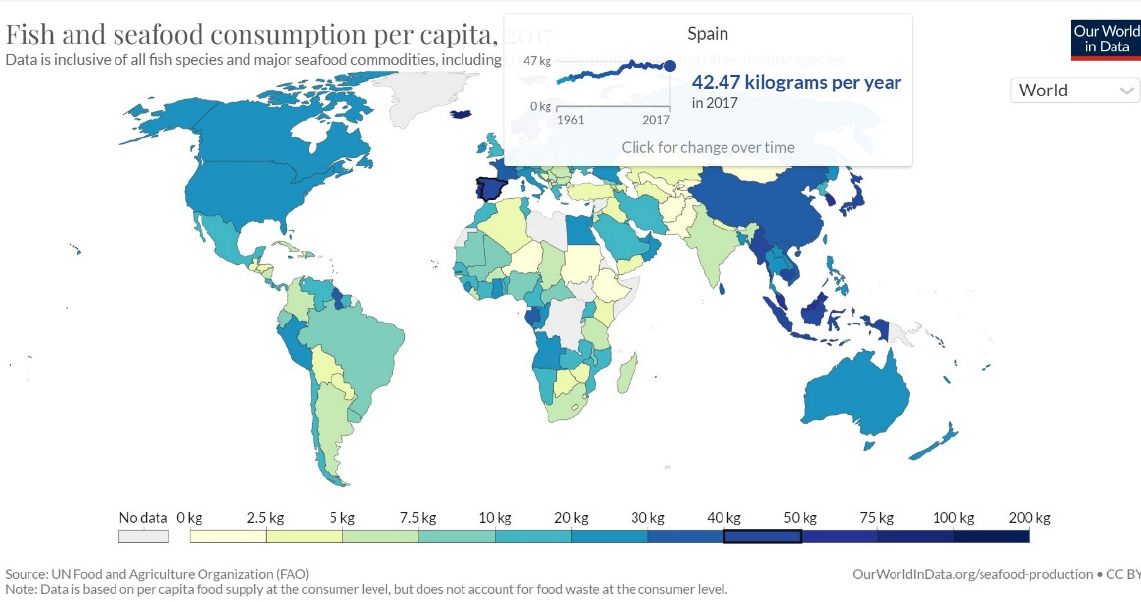
Figure 10. Global land use for food production. Adapted from Ref. [23].